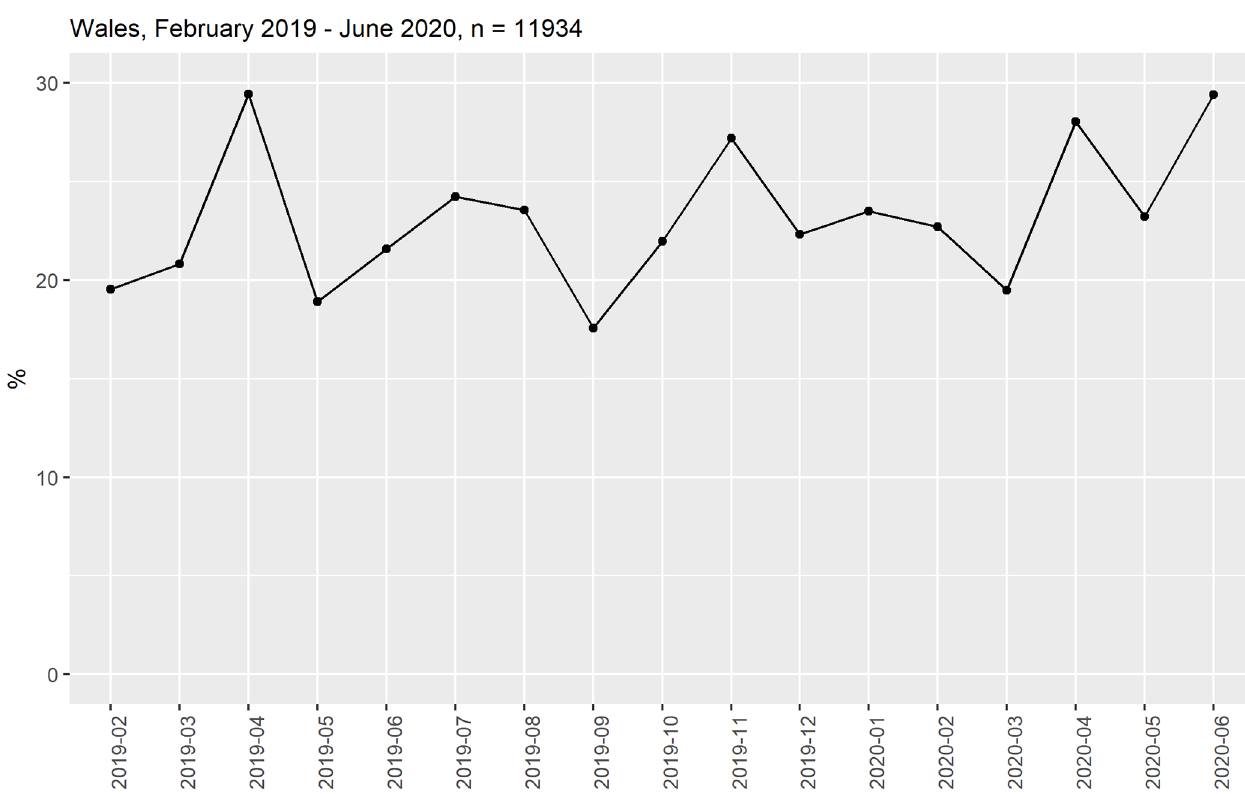
Figure 3: Proportion of NFIB90 crimes recorded in Study 2, per month